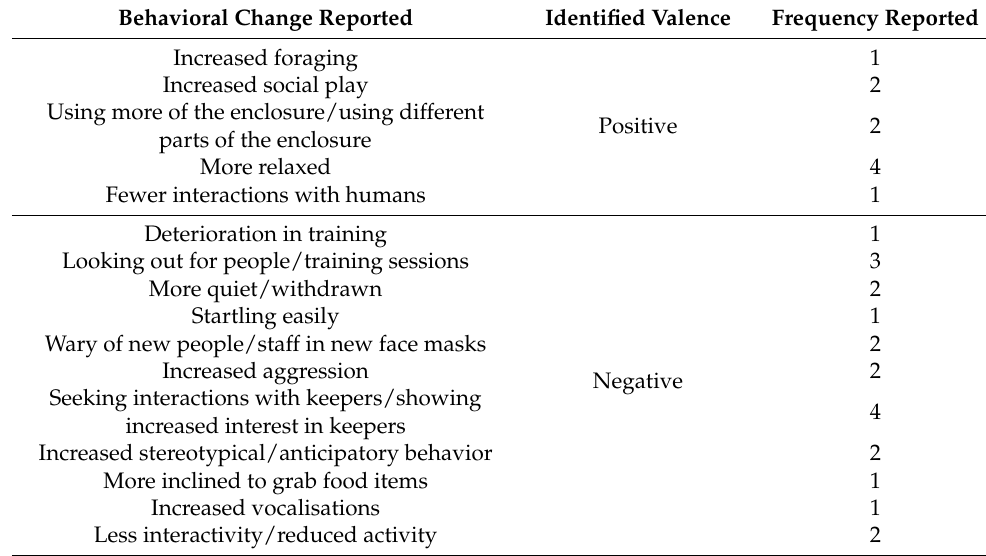
Table 4. A summary of animal behavioral responses, as reported by survey